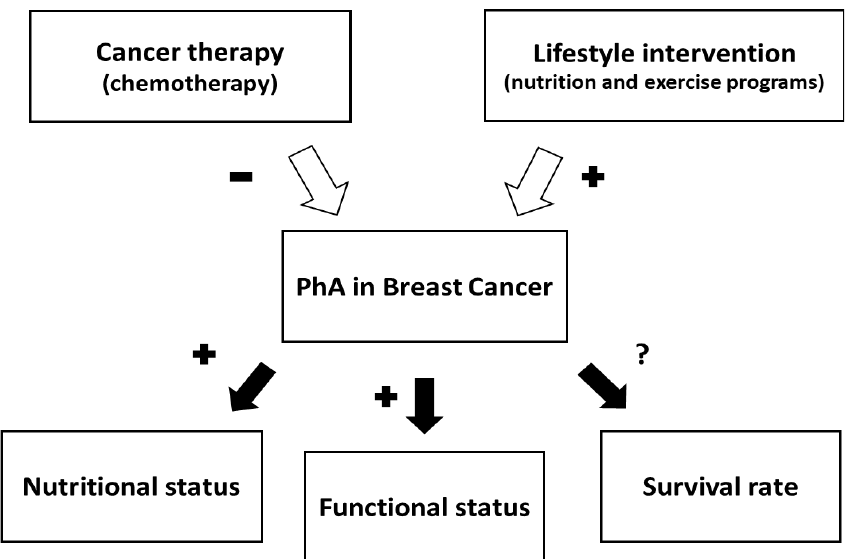
Figure 3. White arrows indicate that PhA is negatively affected by cancer therapy ( − ) and positively by lifestyle intervention (+). Black arrows indicate that PhA serves as a predictor of nutritional and functional status (+) in women with BC, while data are inconsistent about survival (?).